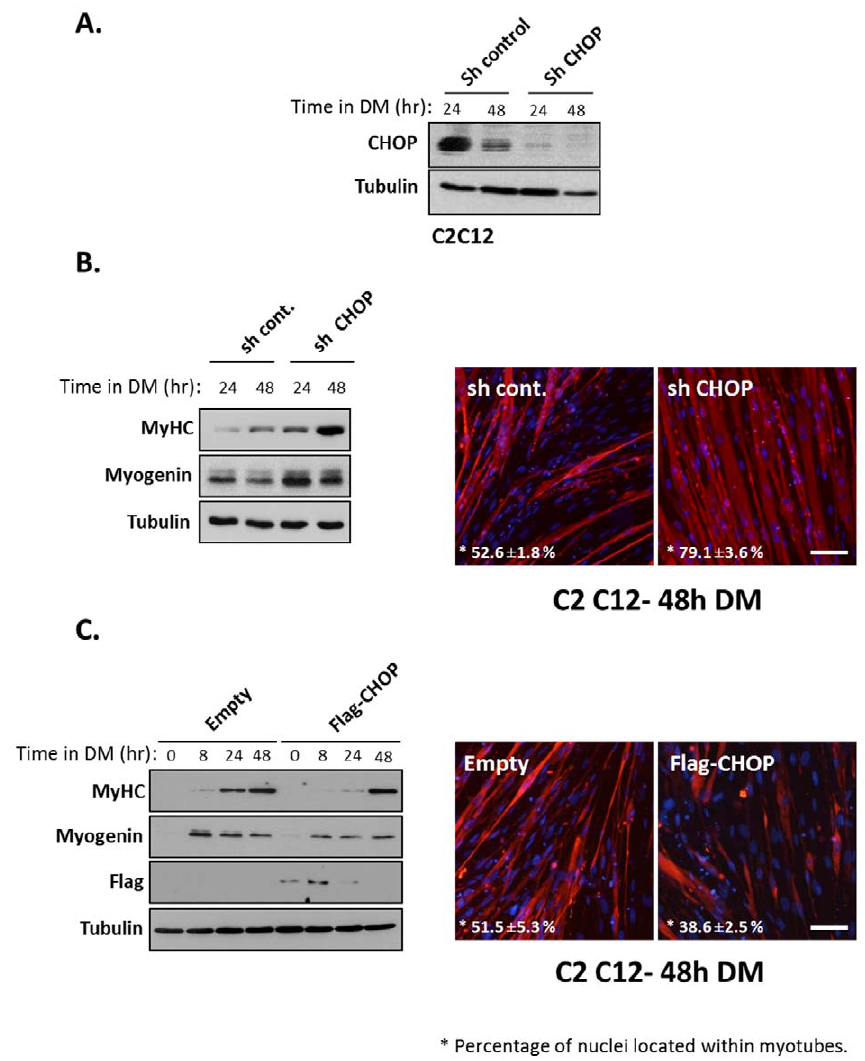
Figure 3. CHOP inhibits myogenic differentiation. (A) CHOP was knockdown in C2C12 myoblasts by infection of lentivirus expressing ShRNA. The levels of CHOP protein were analyzed by Western blot of infected myoblasts. (B) Infected myoblasts were grown in DM for the indicated time periods and myogenic markers were analyzed by Western blot (left panel). Infected myoblasts were grown in DM for 48 hours before cells were immunostained with anti MyHC antibodies (MF20) (right panel) MyHC in red, DAPI in blue. Percentage of nuclei in myotubes was calculated from three independent experiments. Mean values and standard errors are presented. Bar, 50 m m. (C) C2C12 myoblasts were infected with retroviruses encoding a flag-tagged CHOP protein or the parental retrovirus serving as a control. Infected myoblasts were grown in DM for the indicated time periods and myogenic markers were analyzed by Western blot (left panel). Infected myoblasts were grown in DM for 48 hours before cells were immunostained with anti MyHC antibodies (MF20) (right panel) MyHC in red, DAPI in blue. Percentage of nuclei in myotubes was calculated from three independent experiments. Mean values and standard errors are presented. Bar, 50 m m.